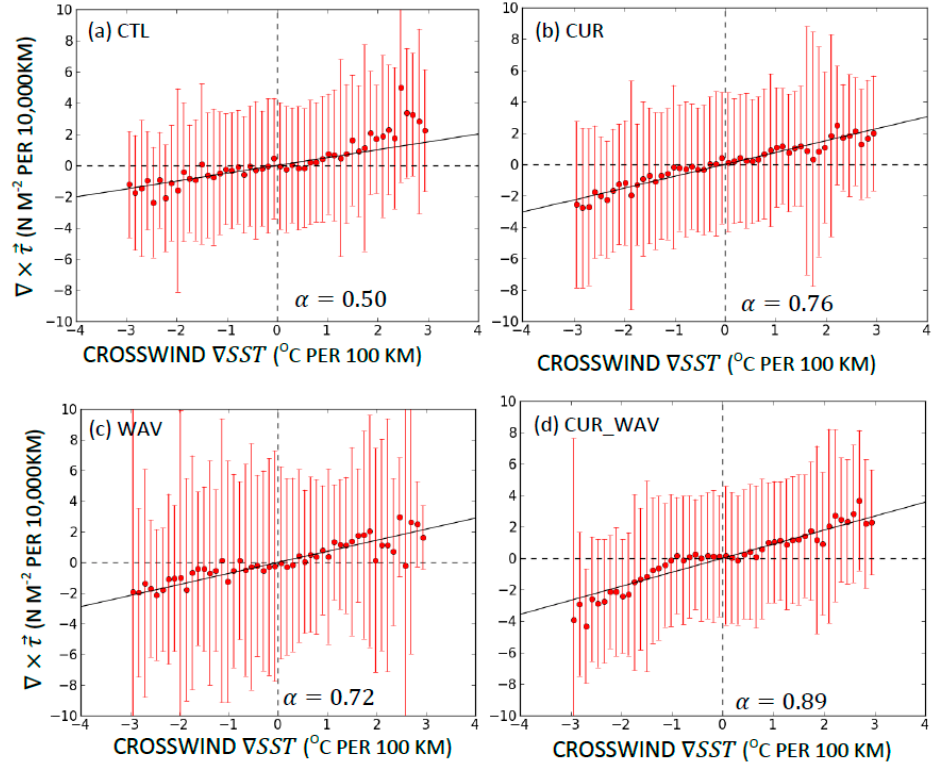
Figure 5. Binned scatterplots of wind stress curl versus the crosswind component of the sea surface temperature (SST) gradient from ( a ) CTL, ( b ) CUR, ( c ) WAV, and ( d ) CUR_WAV. The statistics were computed over the region 35.8N–39.2N, 76W–72W using 30 day averaged fields. The error bars represent the standard deviation within each bin. The slope α of the least squares fit line to the binned average is labeled in each plot.